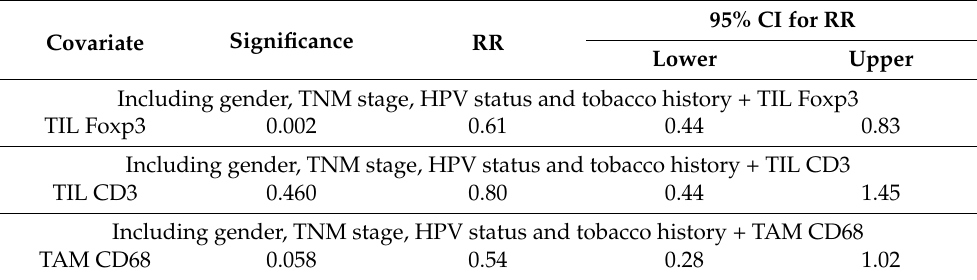
Table 4. Cox multivariate regression five-year DSS analysis including gender at diagnosis, age, TNM stage, tobacco consumption history and epithelial levels of Foxp3 (+) TILs measured as quartiles divided by tumor HPV status. Parameter